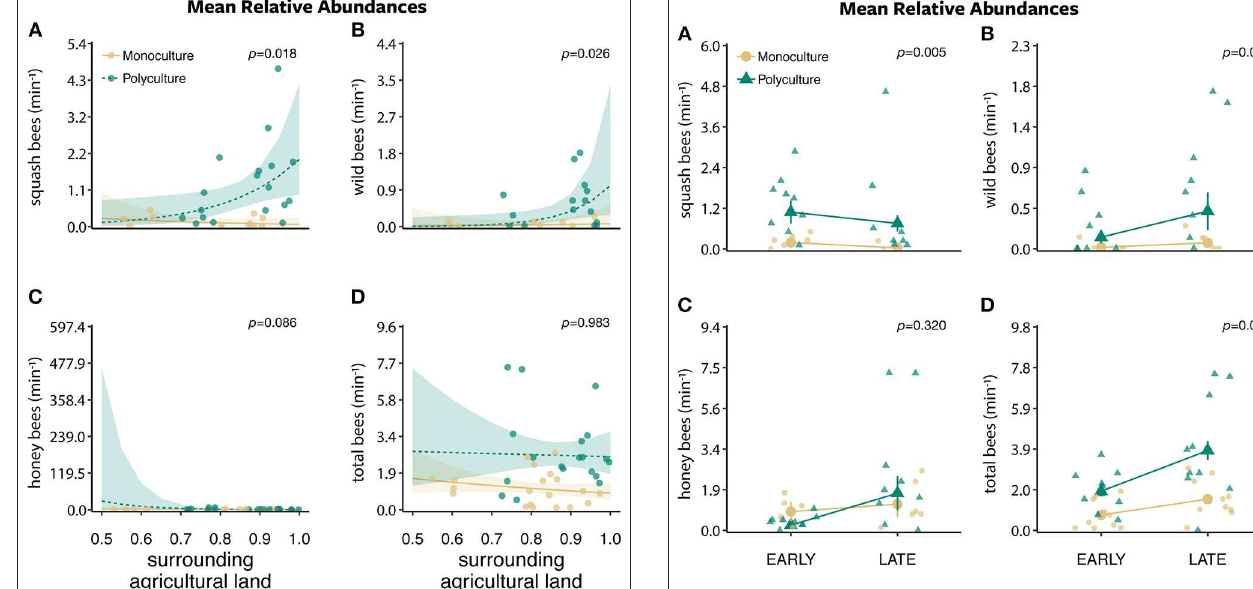
both farm type and proportion of agricultural land ( w = 0.326;